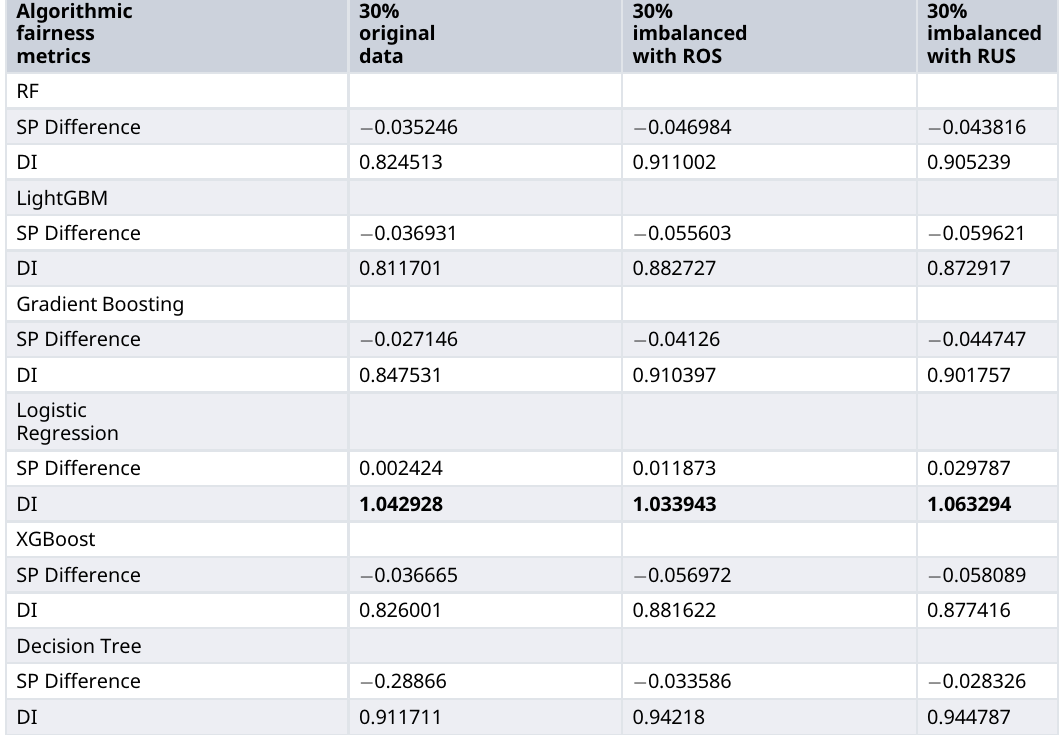
Table 8. The algorithmic fairness measures on 30% unbalanced dataset. Algorithmic